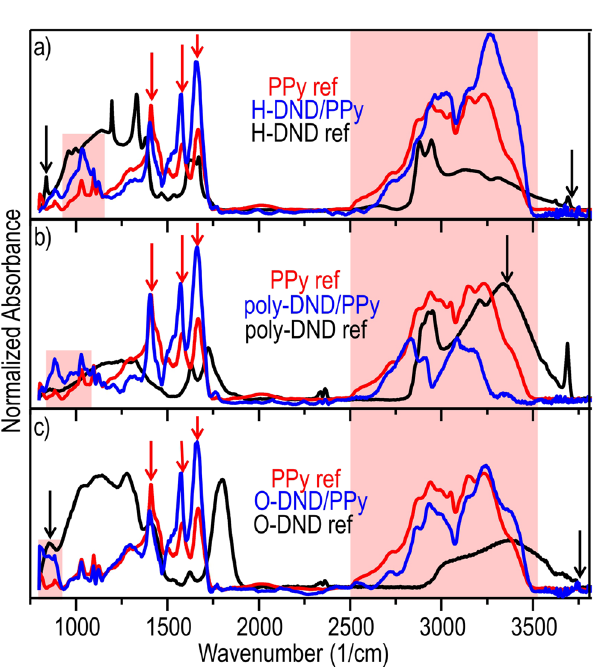
Figure 3. FTIR spectra of ( a ) H-DND/PPy ( b ) poly-DND/PPy and ( c ) O-DND/PPy composites with the reference DNDs and PPy. The remaining features of the pristine materials in the spectra of composites are indicated by arrows, namely pristine DND (black arrows) and PPy (red